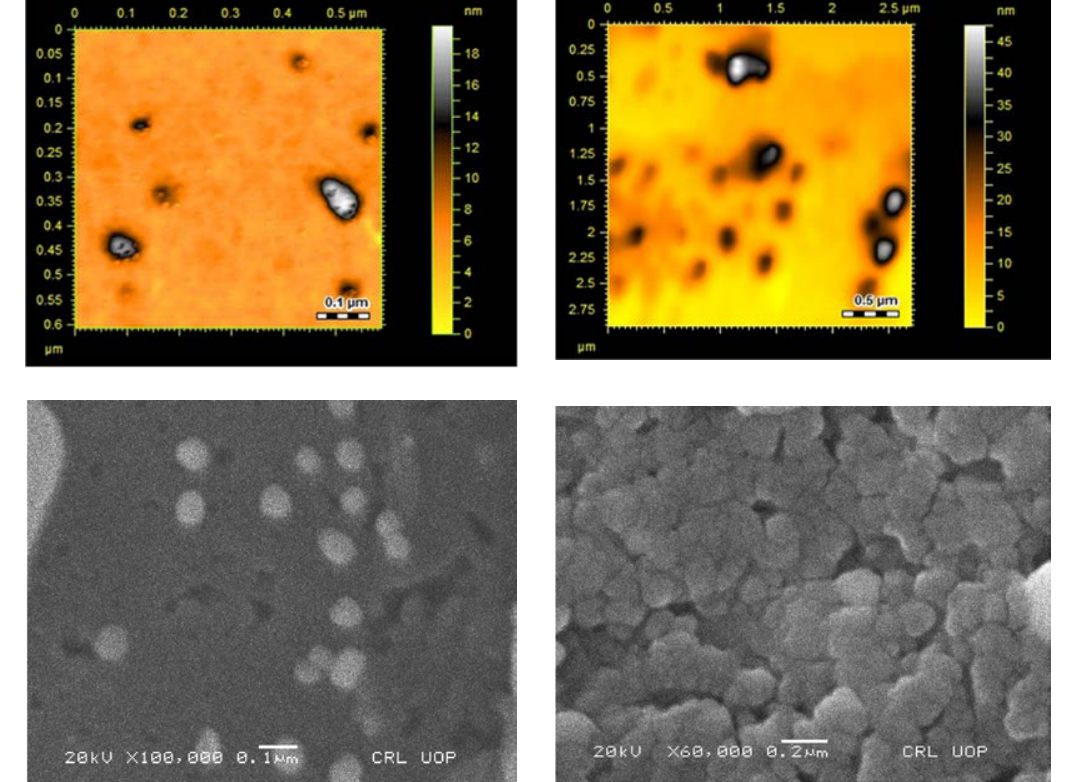
Fig. 3. (a) AFM image of Ag NPs, (b) AFM image of sparfloxacin mediated Au-Sp NPs, (c) SEM images of optimized Ag-Sp NPs, and (d) SEM images of optimized gold